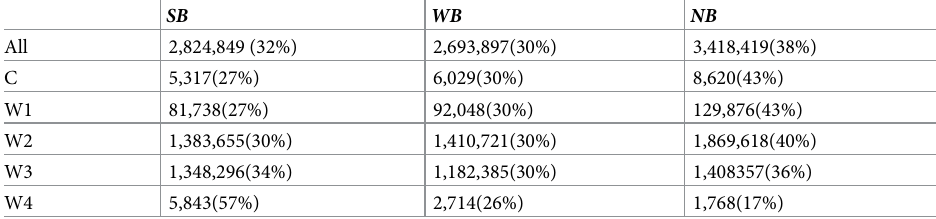
Table 2. Number (percentages with respect to the total number of peptides in the class) of strong, weak and no bind peptides for peptide classes C , W 1 , W 2 , W 3 and W 4 . SB WB NB